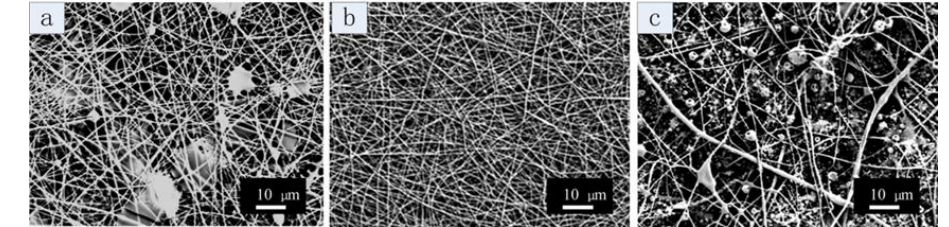
Figure 3. Scanning electron microscopy (SEM) images of coaxial electrospun SF-SELP nanofibers with various SF concentrations: ( a ) 26 wt % ( b ) 29 wt % ( c ) 32 wt %. The concentration of the shell